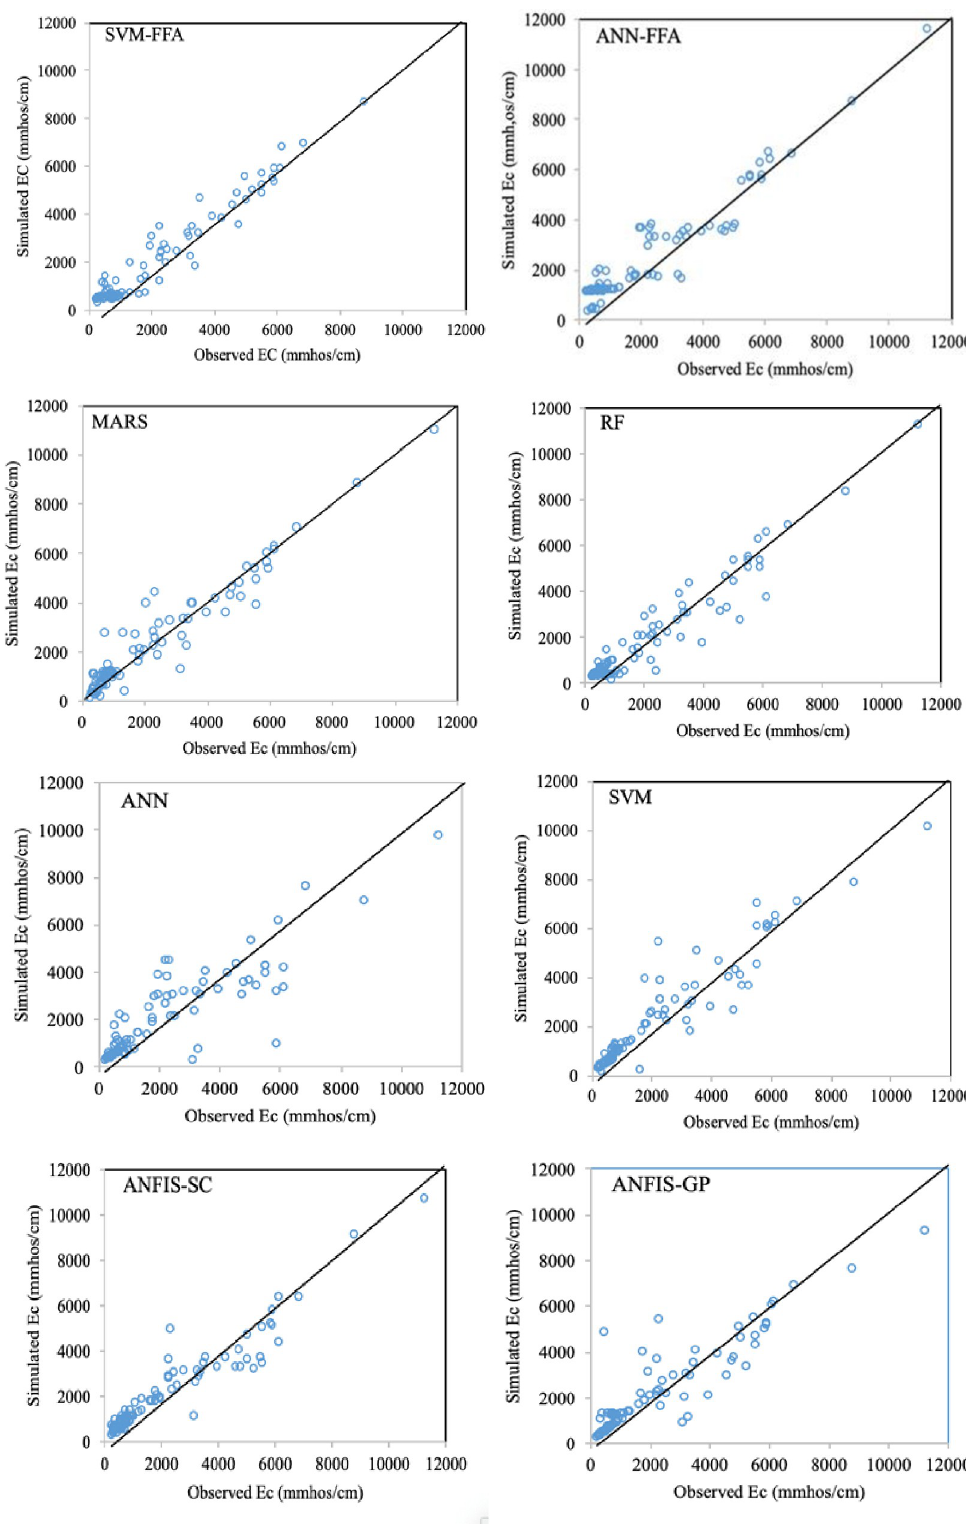
Fig 6. The scatterplots of predicted EC using the applied AI models.